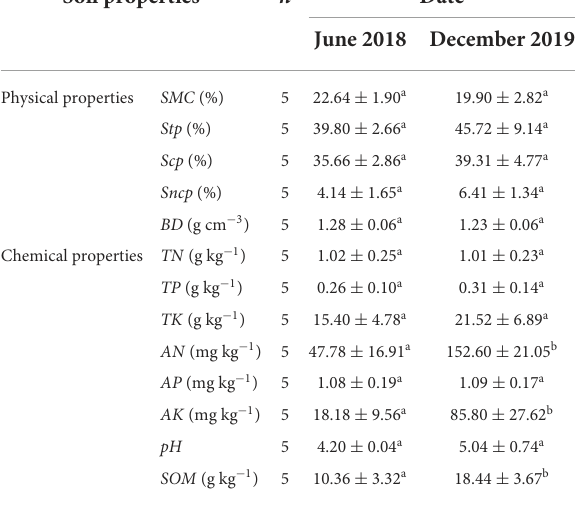
TABLE 3 Measured soil physical properties including soil moisture content ( SMC , %), soil total porosity ( Stp , %), soil capillary porosity ( Scp , %), soil non-capillary porosity ( Sncp , %), bulk density ( BD , g cm − 3 ), and chemical properties including pH values, soil organic matter ( SOM , g kg − 1 ), total nitrogen ( TN , g kg − 1 ), total phosphorus ( TP , g kg − 1 ), total potassium ( TK , g kg − 1 ), available nitrogen ( AN , mg kg − 1